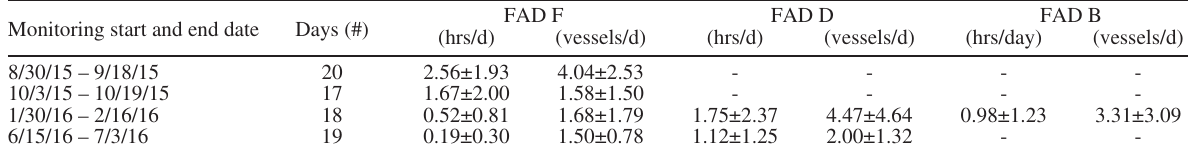
Table 3. – Cumulative vessel presence in terms of hours per day and vessel visits per day for all monitoring periods by FAD off San Juan, Puerto Rico.